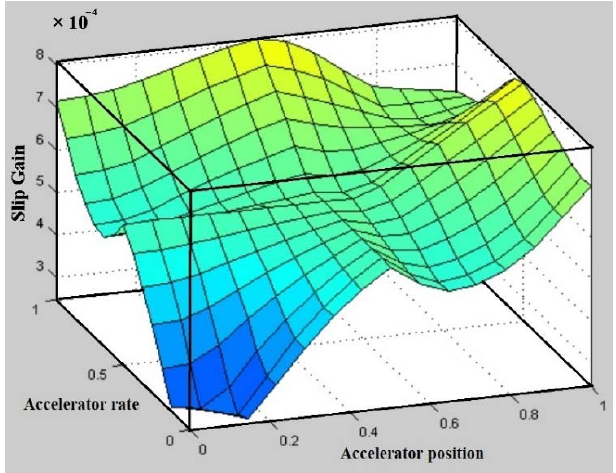
Table 4. Idling law.